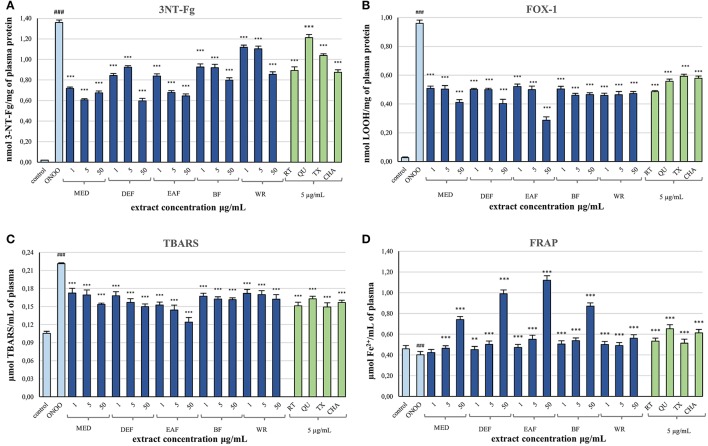
Effects of P. spinosa flower dry extracts on human plasma exposed to oxidative stress: (A) effects on the nitration of tyrosine residues in plasma proteins and formation of 3-nirotyrosine, 3-NT-Fg; effects on the peroxidation of plasma lipids including formation of lipid hydroperoxides, LOOH (B), and thiobarbituric acid-reactive substances, TBARS (C); (D) effects on ferric reducing ability of plasma, FRAP. Results are presented as means ± SE (n = 10) for repeated measures: ###p < 0.001 for control plasma vs. ONOO−-treated plasma (without the extracts); **p < 0.01, ***p < 0.001 for ONOO−-treated plasma in the presence of the extracts (1, 5, or 50 μg/mL) or standards (5 μg/mL) vs. ONOO−-treated plasma in the absence of the extracts. Standards: RT, rutin; QU, quercetin; TX, Trolox; CHA, chlorogenic acid.